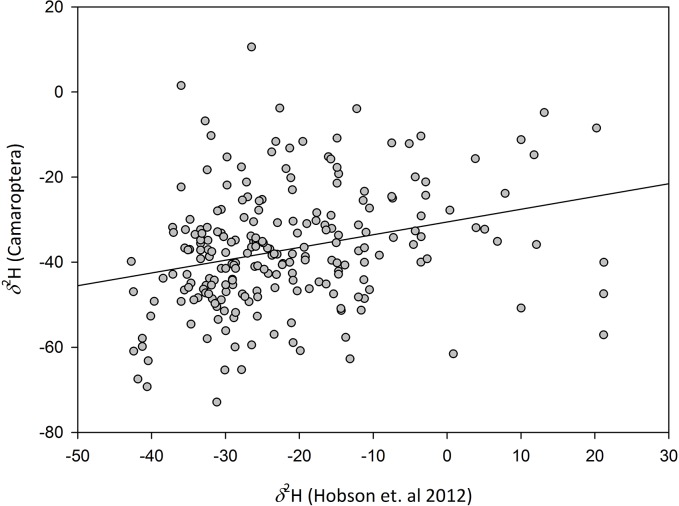
Dispersion plot and regression of Camaroptera δ
2H versus deuterium values from Hobson et al. 2012 [14].